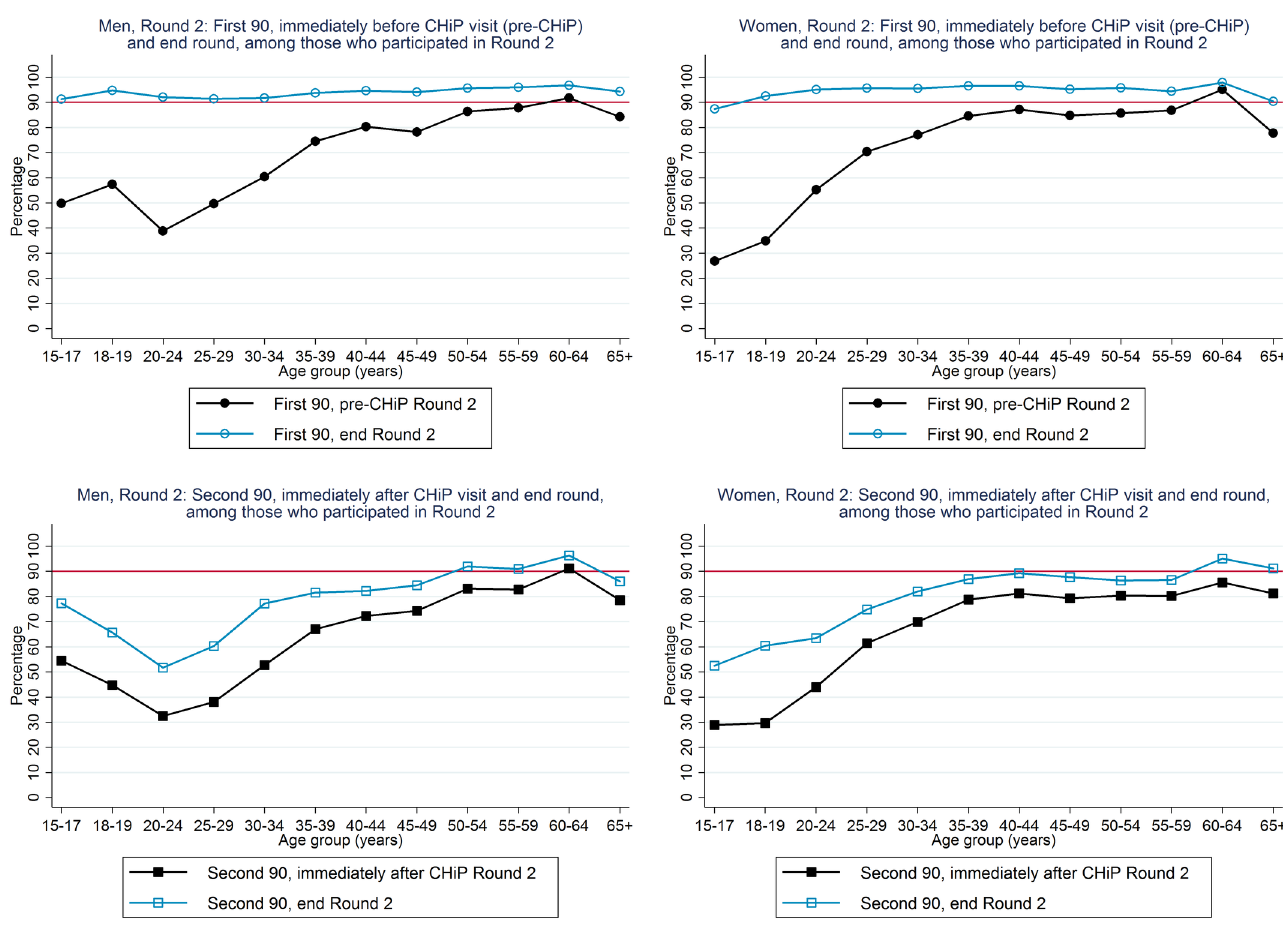
Fig 3. First and second 90 estimates, among individuals who participated in Round